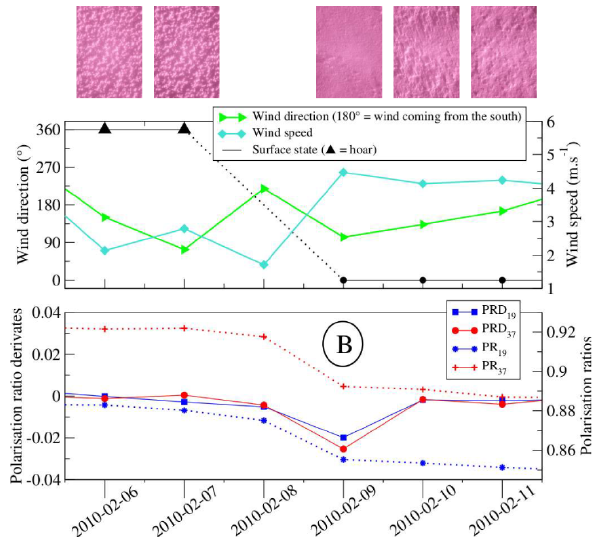
Fig. 9. Disappearance of hoar crystals (unscaled black symbols and small pictures above the graph) present at the surface on 9 February 2010 at Dome C (event B in Fig. 7). Between the 8 and 9, a decrease of polarisation ratios at 19 and 37 GHz and highly negative values of their derivatives (respectively PRD 19 and PRD 37 ) are observed, as well as a change in wind direction (wind coming from southwest to wind coming from southeast) and a twofold increase of wind